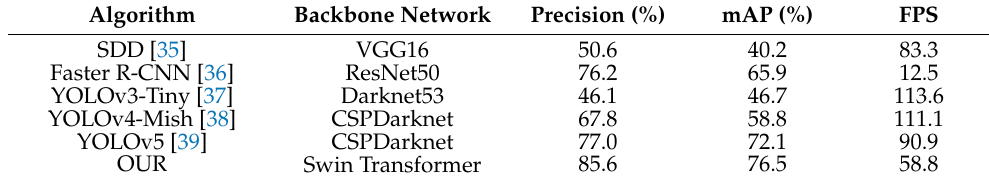
Table 6. Comparison with state-of-the-art methods.